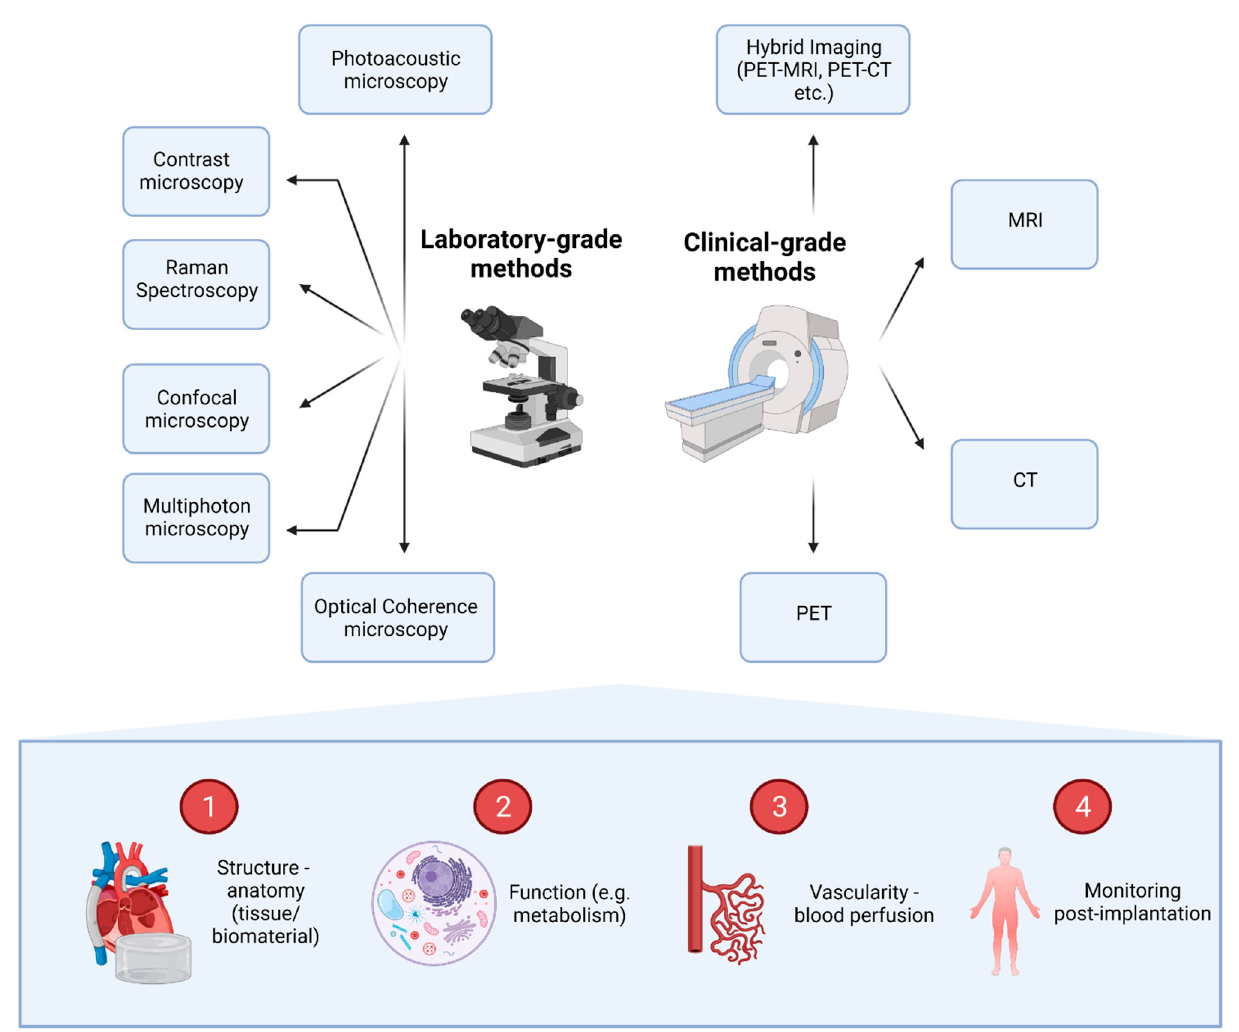
Figure 3. Imaging methods available for the evaluation of 3D tissues and the information that they can provide. A series of laboratory-grade and clinical-grade methods can be utilised to provide information on four main domains. Images can demonstrate anatomical and functional information (e.g., metabolic information). In addition, imaging can reveal and quantify tissue vascularity and perfusion of blood, while providing information about the fate of constructs post-implantation, uncovering potential